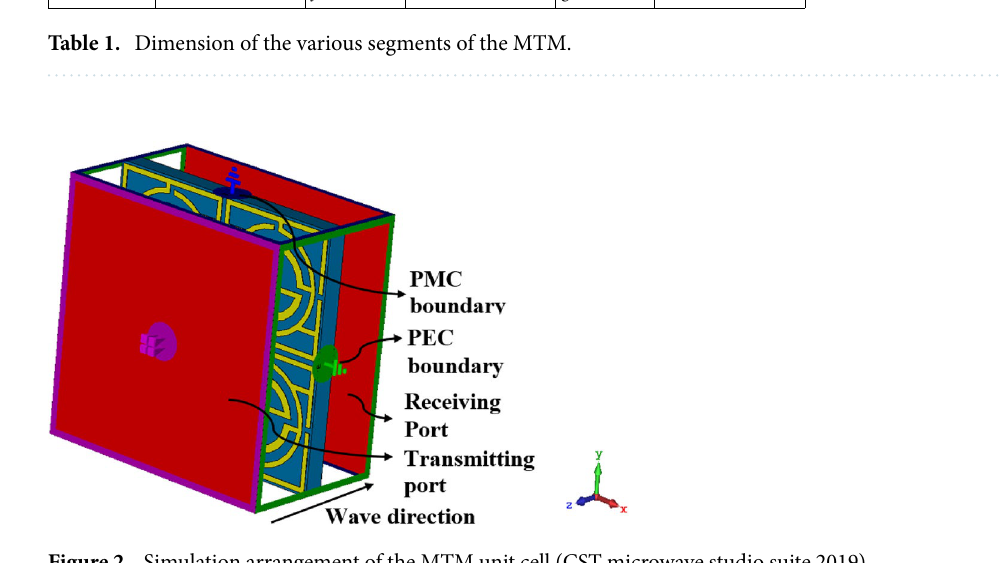
Figure 2. Simulation arrangement of the MTM unit cell (CST microwave studio suite